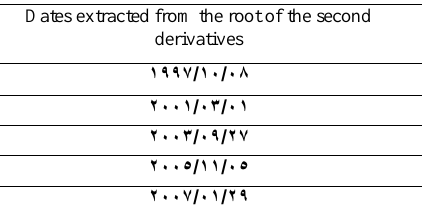
Fig. 8. Extracted total water level changes of the Urmiah Lake for the years 1998 to 2006. Table 4. Computed salient